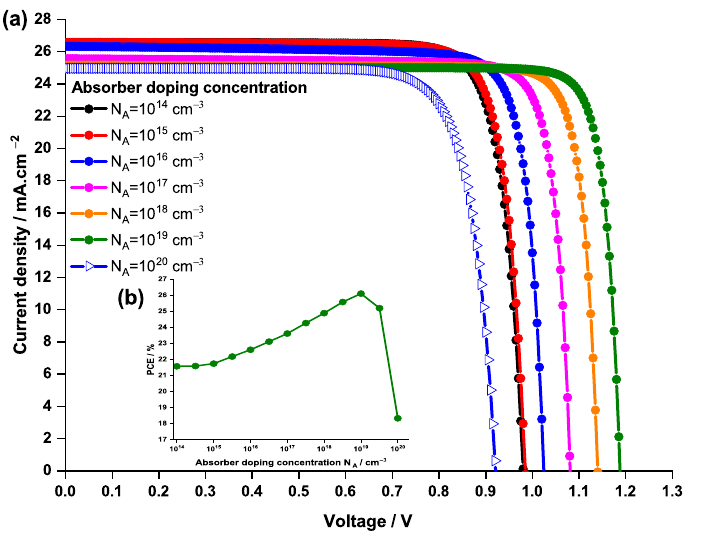
Figure 13. Effect of the doping concentration of the absorber on ( a ) the current density—voltage characteristics of the PSC and ( b ) the